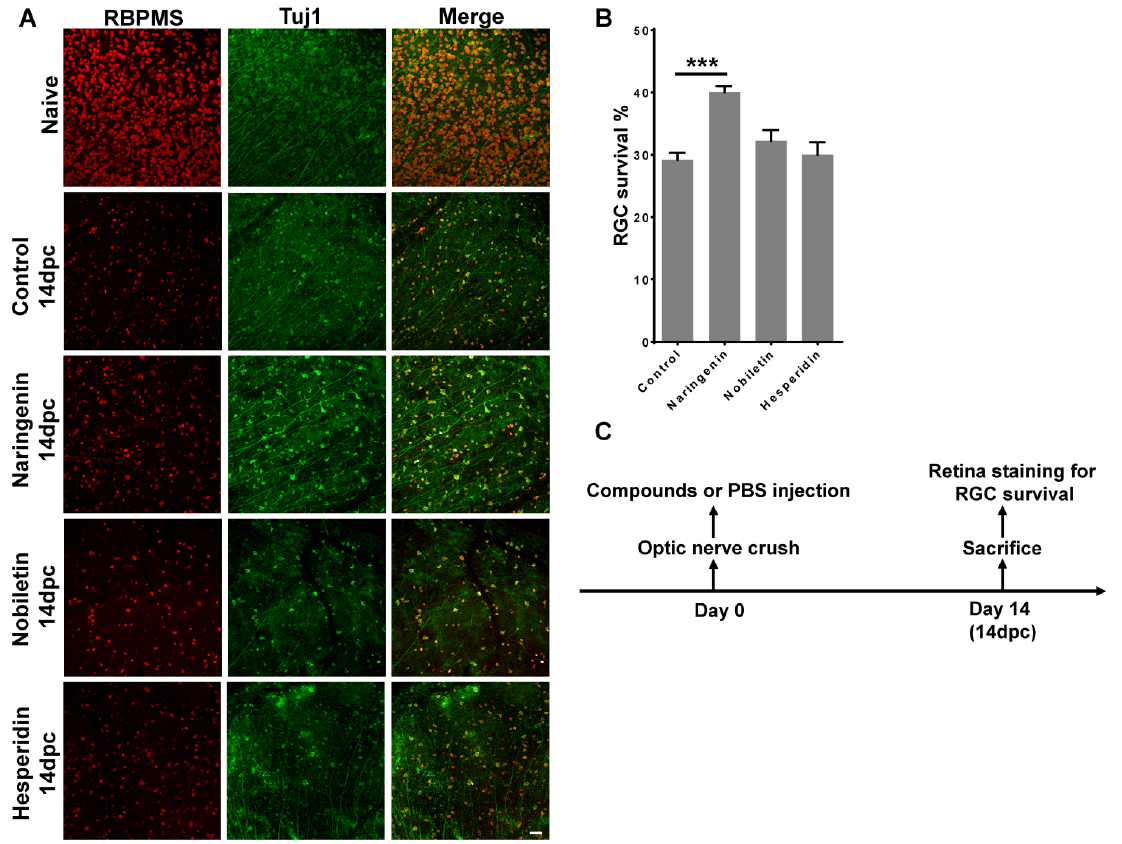
Figure 3. Neuroprotection effects of RGCs in traumatic optic nerve injury model after treatment with citrus components. ( A ) Representative images of naïve retina, 14 dpc retina, and 14 dpc retina after treatment with naringenin, nobiletin or hesperidin, respectively. Retinas were co-immunostained with rabbit antibody against RGC specific marker-RBPMS and mouse antibody against neuron specific marker- β III tubulin (Tuj1). Scale bar: 50 µ m. ( B ) Statistical analysis of percentage of survived RGCs in groups treated with compounds relative to naive control retina. Data are represented as mean ± SEM, n = 7; *** p < 0.001. ( C ) The chronogram of the mouse experiments for RGC survival study. 14 dpc: 14 days post-crush; RGCs, retinal ganglion